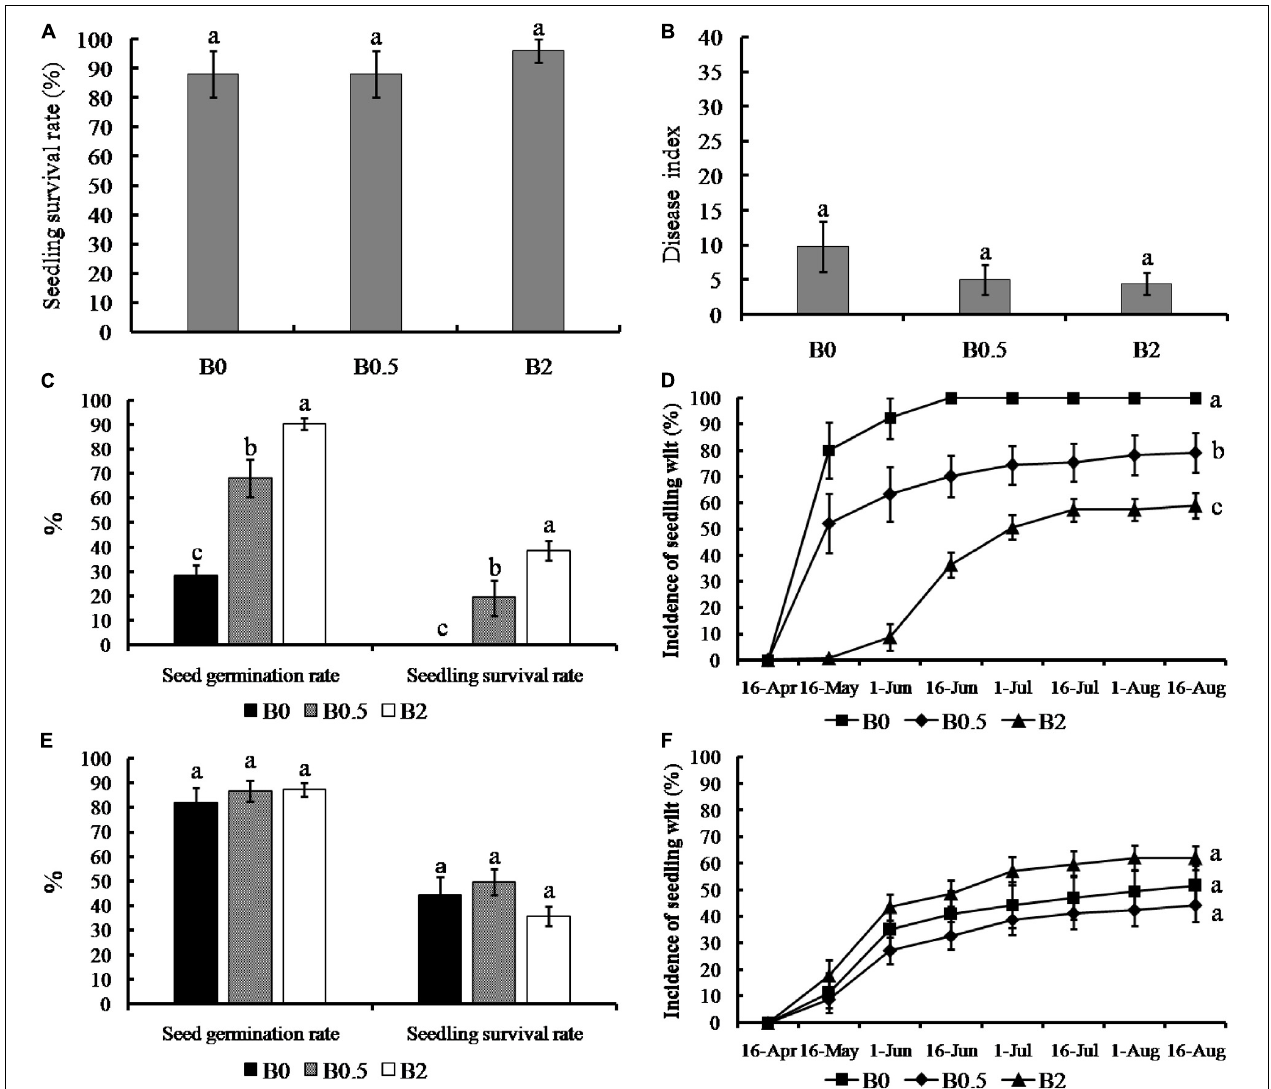
FIGURE 1 | Effect of biochar amendment on seedling survival, root rot disease severity and plant-soil feedback of sanqi. Panel (A,B) shows the effect of biochar on seedling survival rate and the disease index of sanqi root rot in the uncultivated soil, respectively; (C) shows the seed germination and seedling survival rate of sanqi in consecutively cultivated soil; (D) shows the disease progress curves of sanqi seedling wilt in consecutively cultivated soil; (E) shows the seed germination and seedling survival rate in consecutively cultivated soil with heat-treated; (F) shows the disease progress curves of sanqi seedling wilt in consecutively cultivated soil with heat-treated. B0, B0.5, and B2 stand for biochar soil amendment at a concentration of 0, 0.5, and 2% (w/w), respectively. All data are presented as the mean ± standard errors (SE) and bars indicate SE. The different letters above the error bars indicate significant differences among the treatments ( p < 0.05; n = 5; Duncan’s multiple range